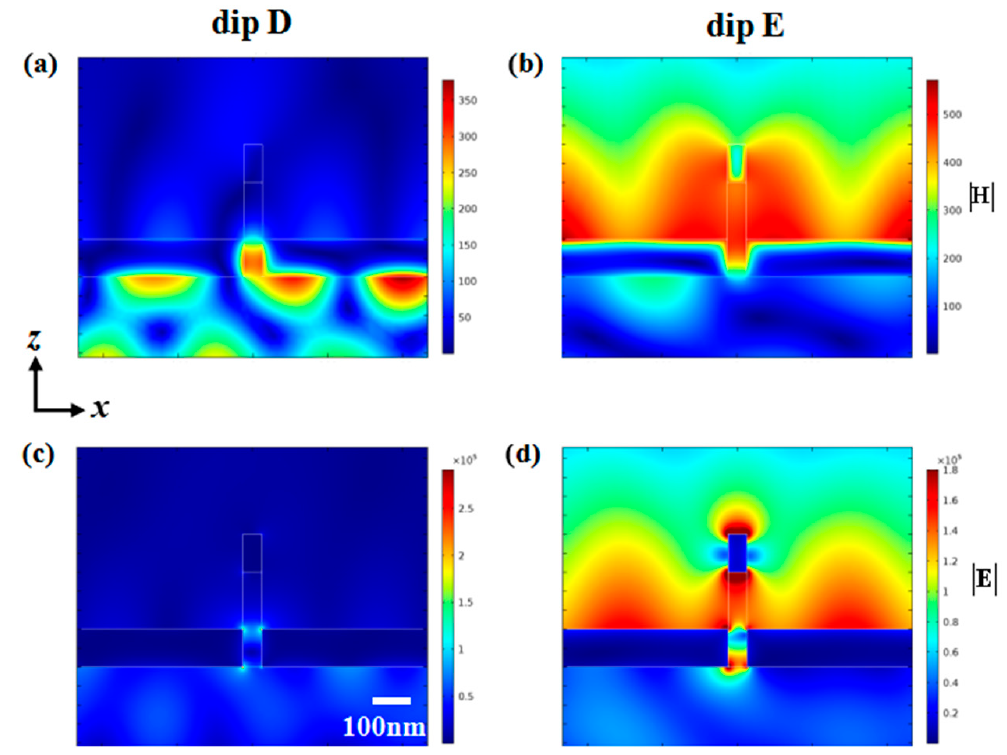
Figure 6. Near-field distribution at resonant dips when the incident angle is 30°. Magnetic field distribution of ( a ) dip D and ( b ) dip E. Electric field distribution of ( c ) dip D and ( d ) dip E.